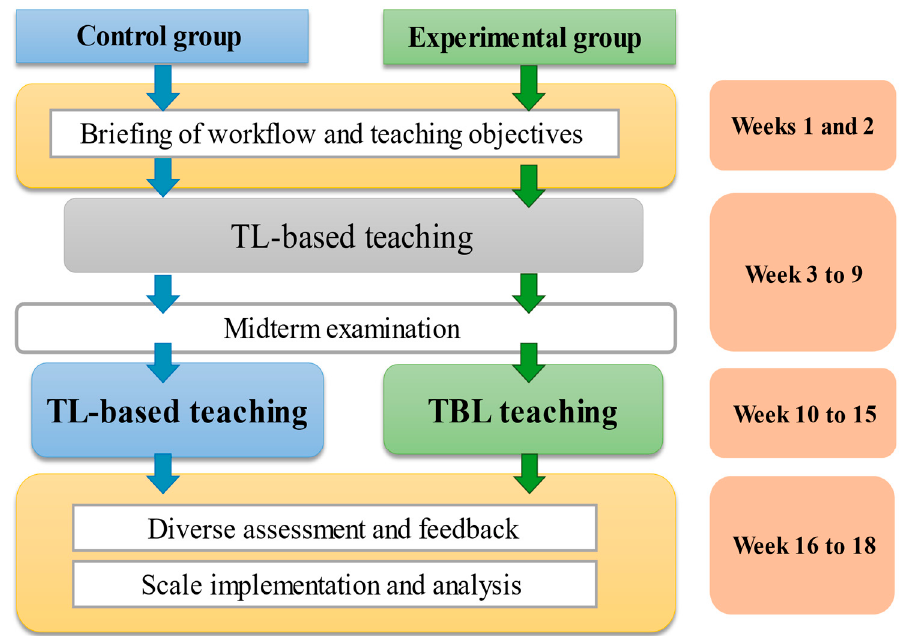
Figure 1. The research design